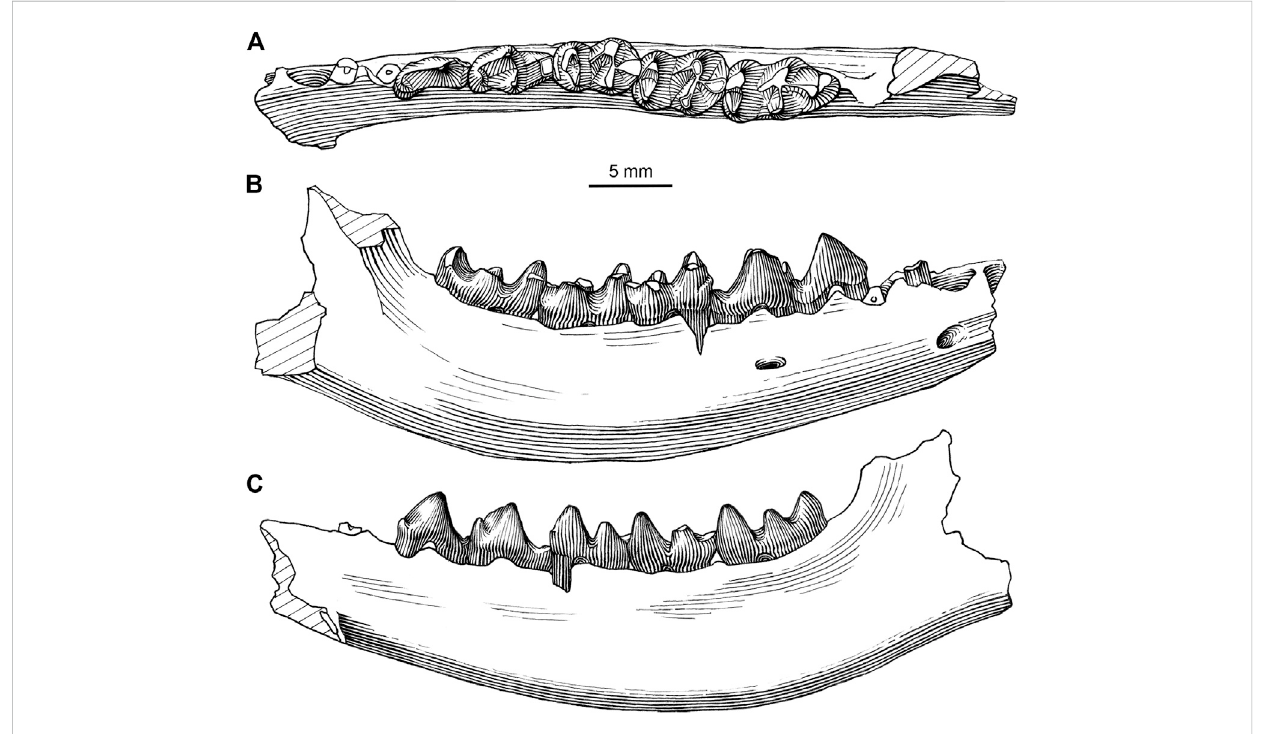
FIGURE 5 Line drawing of the right lower jaw of Obotherium tongi gen. et sp. nov. with p3-m3 and alveoli of canine, p1, and root of p2 (IVPP V 31731). (A) occlusal view; (B) buccal view; (C) lingual